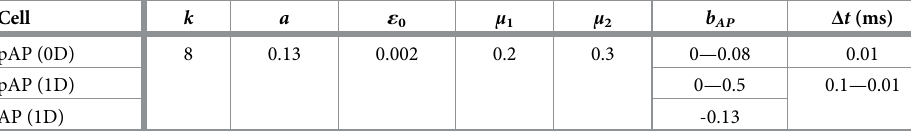
Table 1. Parameters for the pAP and AP models used in the 0D (isolated cell) and 1D simulations.